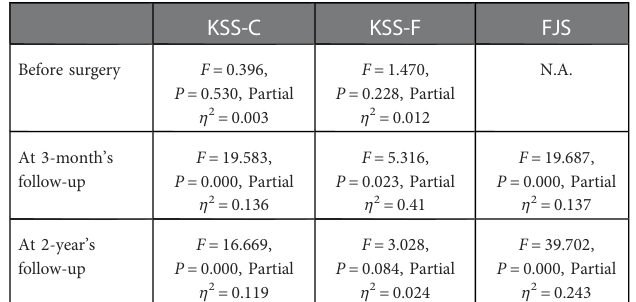
TABLE 4 The statistical results of the simple effect test of time in the KA and MA